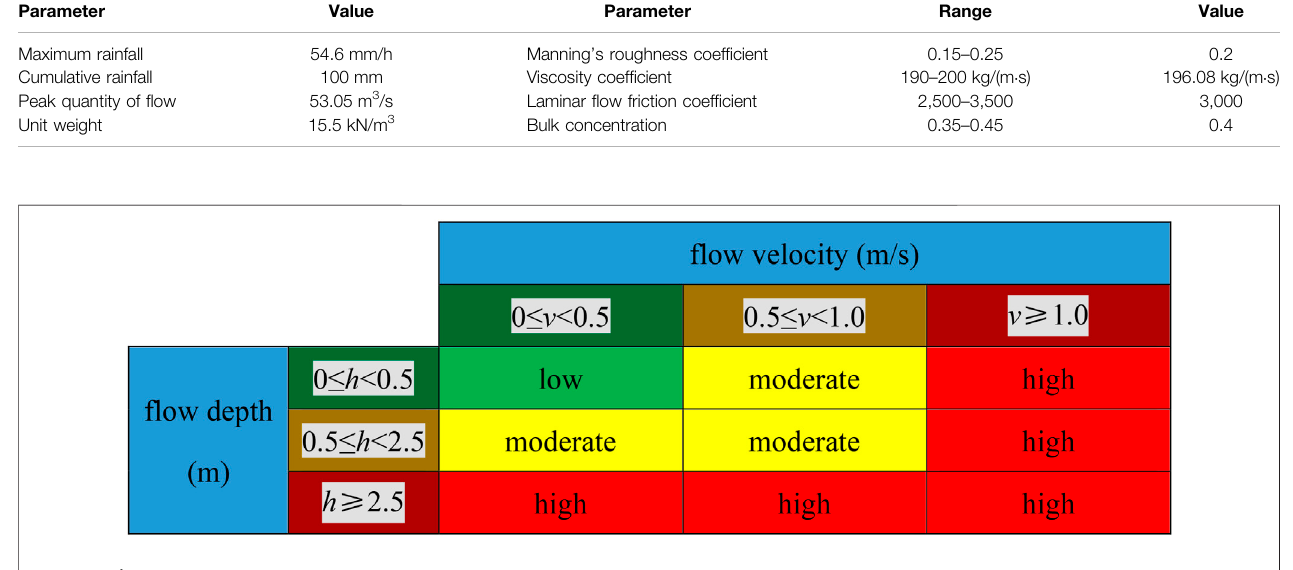
FIGURE 6 | Intensity matrix for the debris fl